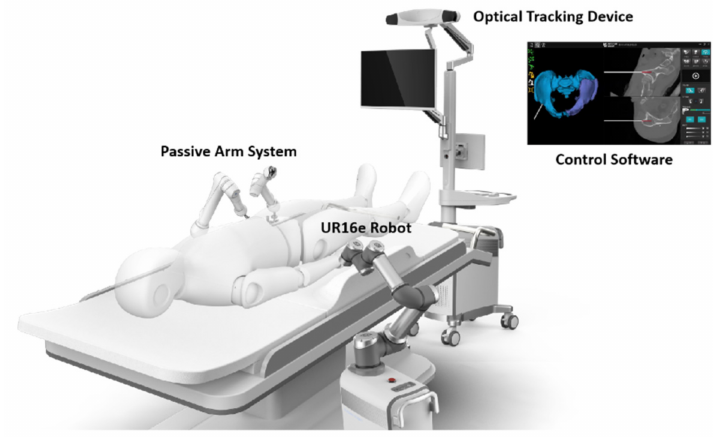
Figure 1. Diagram of the robot